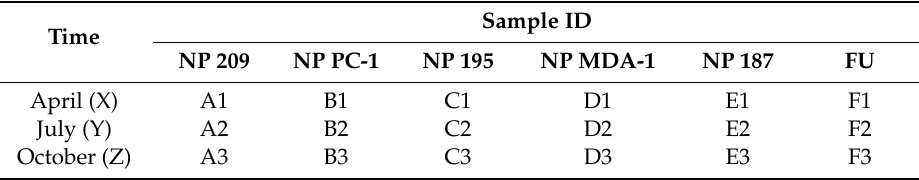
Table 1. Highlights of the sampling time and